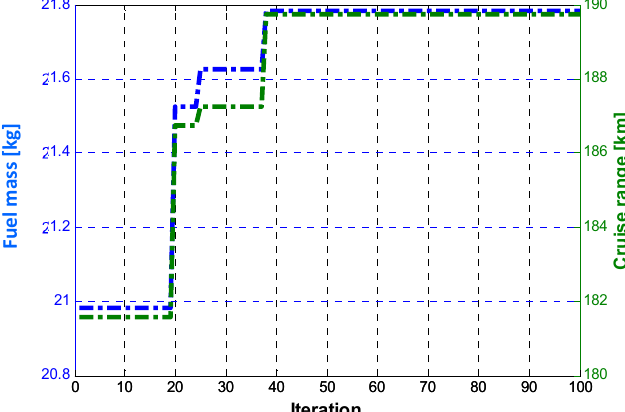
Figure 7. Variation of solutions for the fuel mass and cruise range in optimization Problem 1.